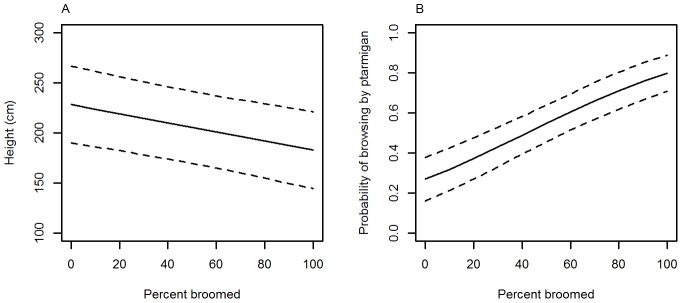
Relationship between percent of feltleaf willow (Salix alaxensis) branches that were broomed and plant height (a) and the probability of browsing by ptarmigan (b).Mixed models were used to assess the strength of relationships, with proportion of broomed branches as the fixed effect, and site as therandom effect. Dotted lines indicate upper and lower 95% confidence intervals.